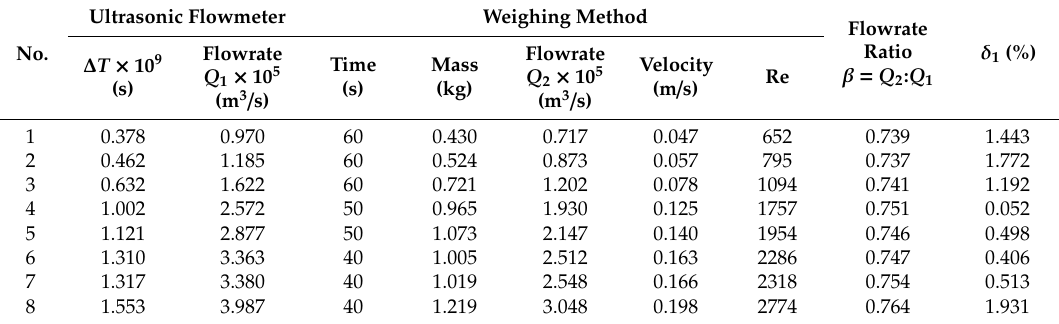
Table 2. Results of flowrate measured at the Reynolds’ apparatus.